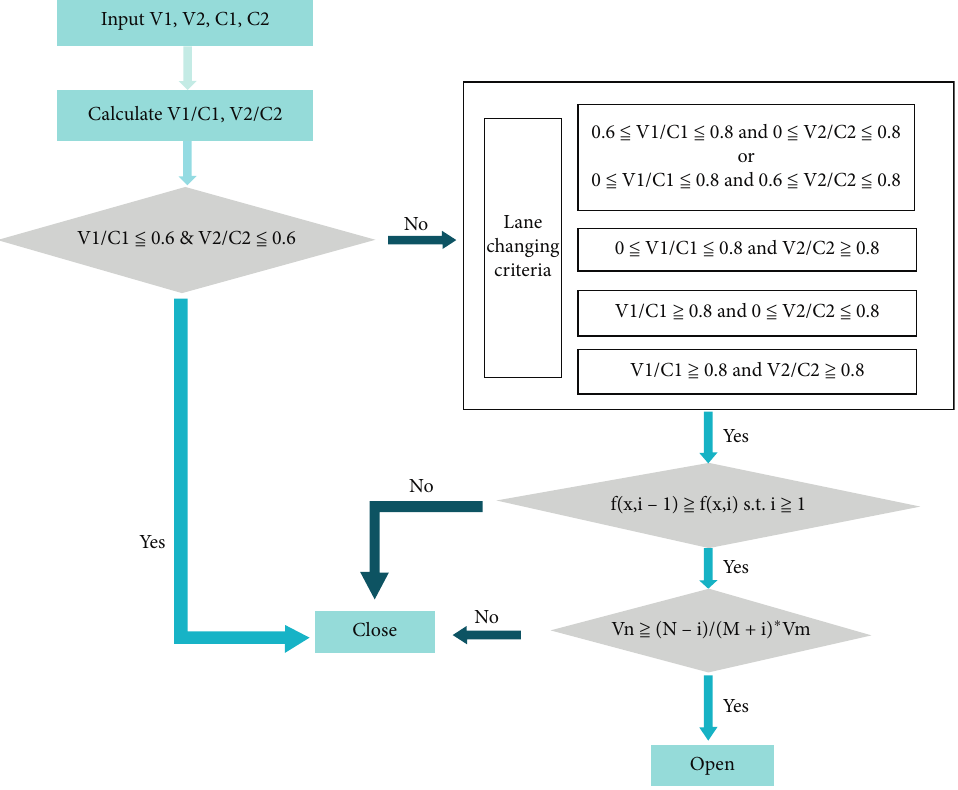
Figure 1: Dynamic control model flow chart, where V m and m are traffic volume and number of lanes in the congested direction, re- spectively, V n and n are traffic volume and number of lanes in the opposite direction, i refers to number of reversible lanes, and when f ( x, i − 1 ) ≥ f ( x,i ) , the number of reversible lanes equals to i .